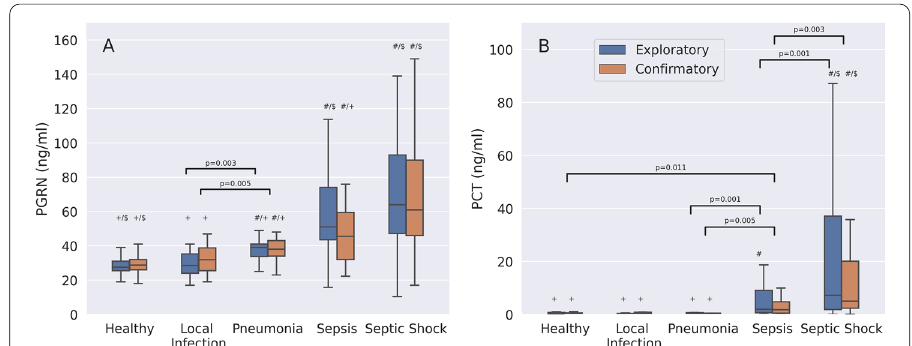
Fig. 2 Comparison of progranulin (PGRN, A ) and procalcitonin (PCT, B ) plasma concentrations between healthy controls and patients with either a severe localized infection (e.g., a large peripheral abscess at high risk for sepsis), non‑COVID‑19 community‑acquired pneumonia (CAP), sepsis or septic shock. Data are presented separately for the exploratory (blue boxplots) and the confirmatory study (orange boxplots). All symbols indicate p < 0.001. Significant p ‑values 0.001 are given as numbers in addition to symbols. ≥ # Indicates a significant difference between patients with sepsis, septic shock or CAP when compared to healthy controls. $ Indicates a significant difference between patients with sepsis, septic shock or healthy controls when compared to patients with CAP. Indicates a significant difference between patients with + sepsis, CAP or healthy controls when compared to septic shock patients